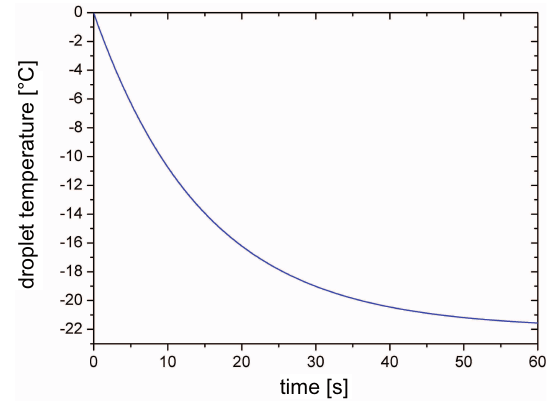
Figure A1. Development of droplet temperature during cooling in the